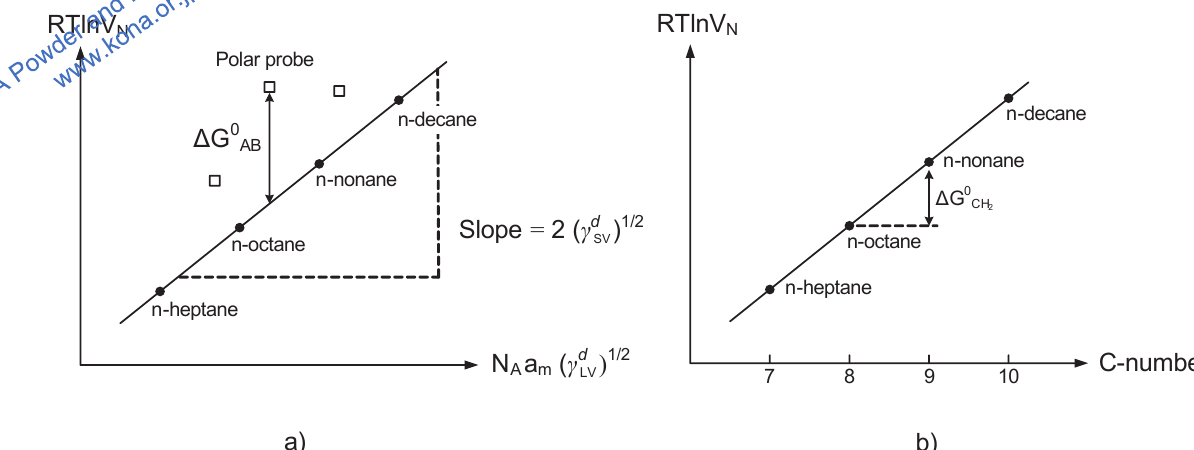
Fig. 3 Determination of solid-vapor surface free energy and acid/base free energy change of adsorption from a) the Schultz approach and b) the Dorris-Gray